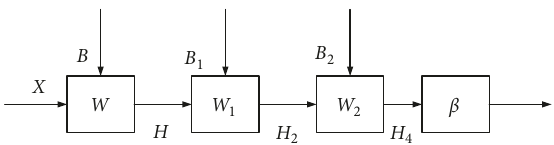
Figure 1: The workflow of the MELM approach.